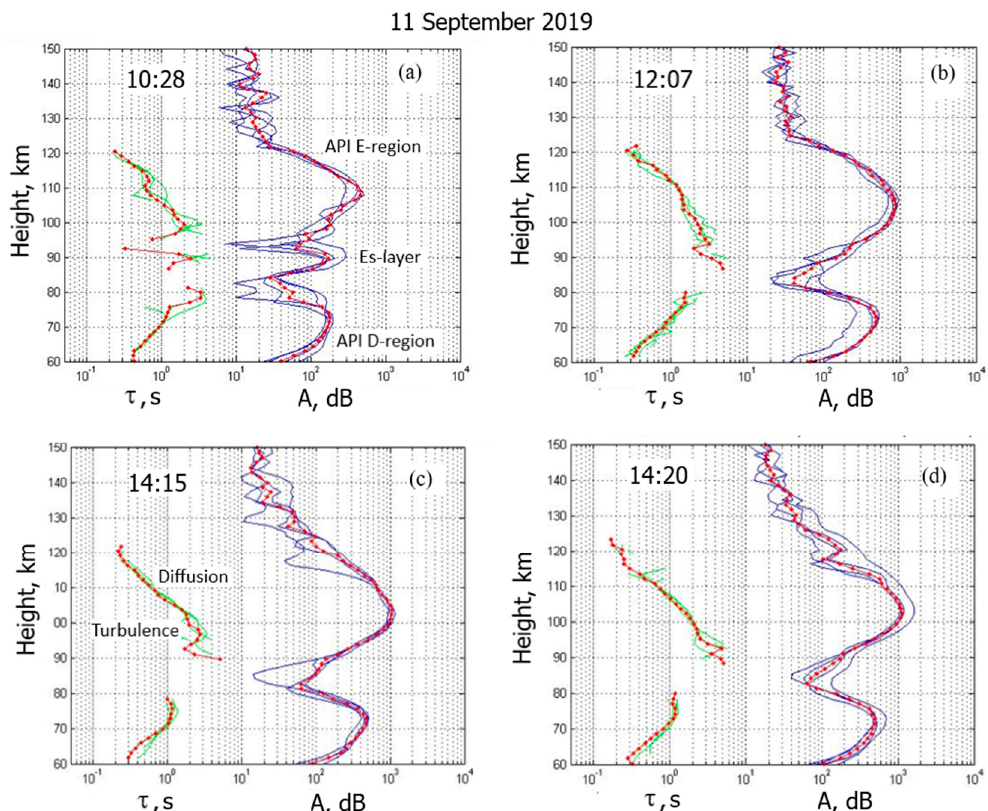
Figure 5. Height dependences of the amplitude A ( right curves) and relaxation time τ ( left curves) of the API scattered signal in the D-region (h = 60–80 km) and in the E-region (h = 90–120 km) for four sessions of the API recording with a duration of one minute. Blue curves for amplitude and green curves for relaxation time show the dependences A(h) and τ (h), obtained in every 15 s of the API recording. Red curves with dots show the altitude dependences of the amplitude and relaxation time averaged over one minute. Session time is shown in the figures in the format hours: minutes ( a ) 10:28, ( b ) 12:07, ( c ) 14:15, ( d ) 14:20.